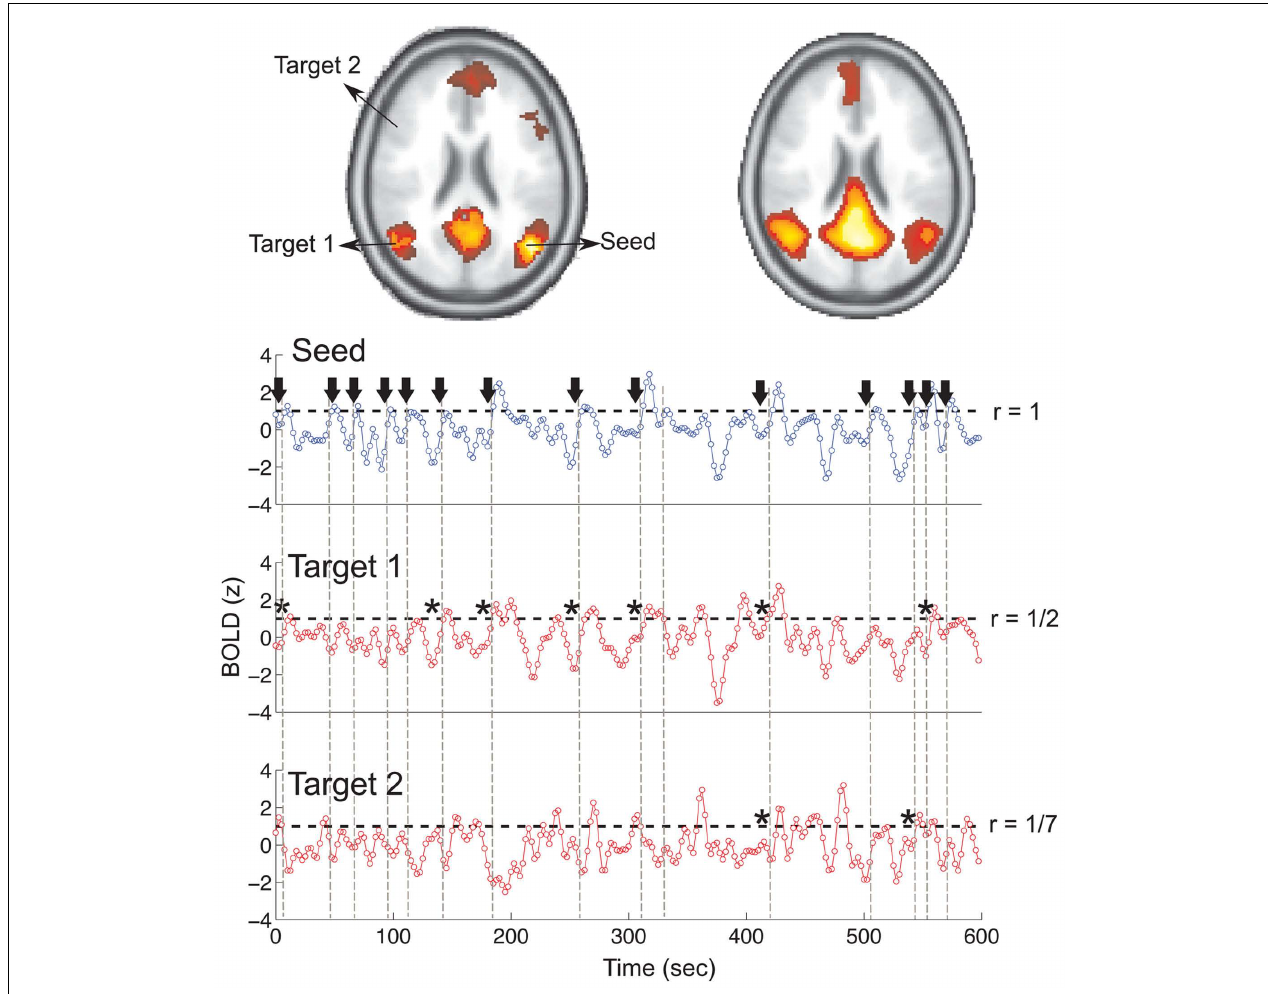
FIGURE 6 | Illustration of the basic procedure to calculate the conditional rate maps presented in Figure 2. The r values on the right side of the traces